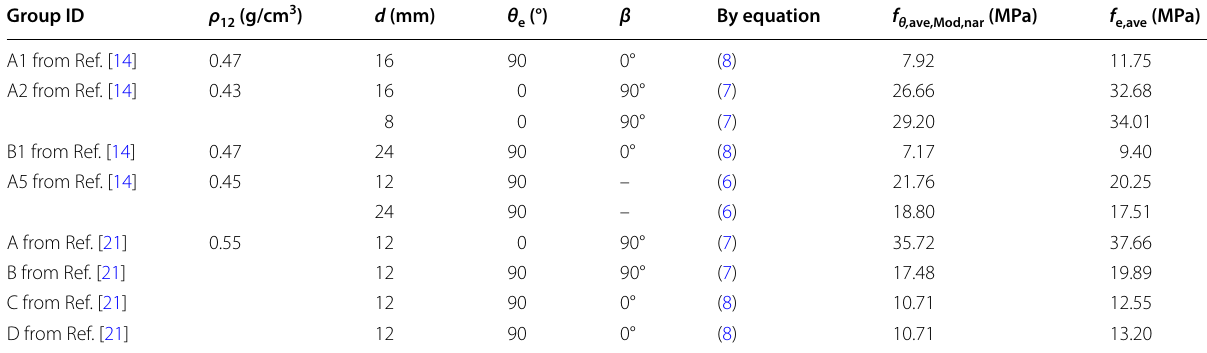
Table 5 Verification of the modified equations based on the test data from the references Group